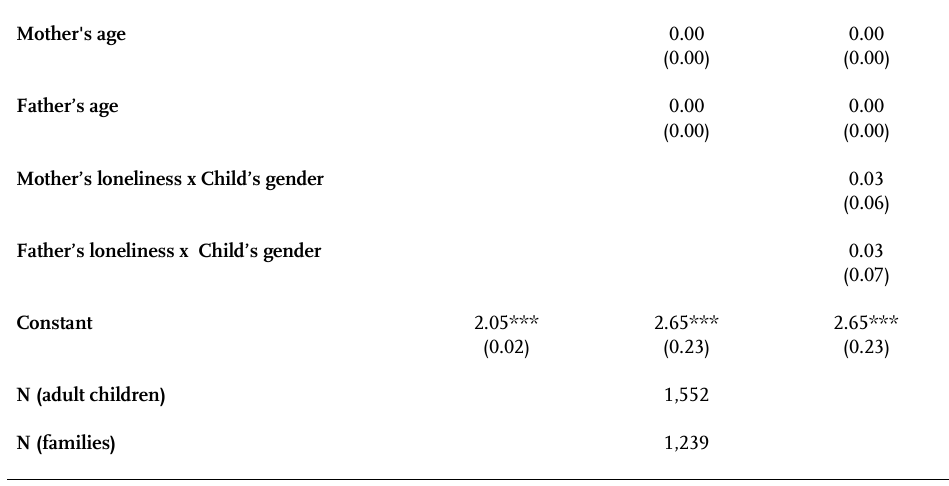
Table 4 : Multilevel regression: The relationship between loneliness in parents and their adult children living in their own household (unstandardized coefficients)